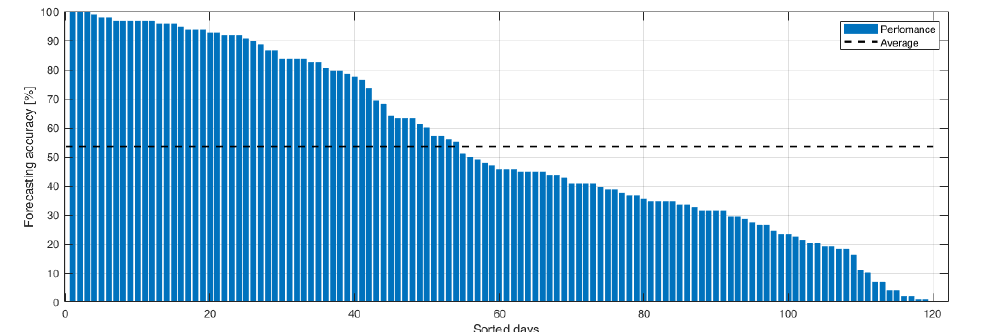
Figure 9. Sorted daily forecasting performance corresponding to a time horizon of 5